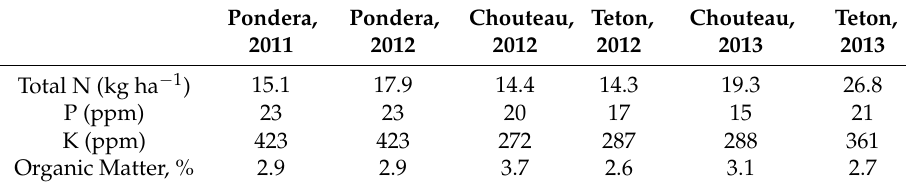
Table 2. Preplant soil test results (0–60 cm) for six site-years in Montana.